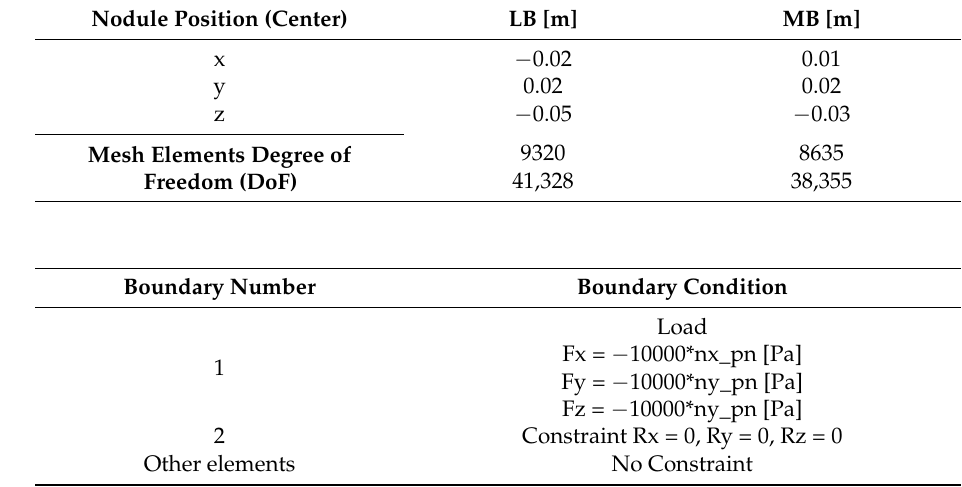
Figure 5. Three-dimensional (3D) model for FE analysis with 10-mm diameter inclusion embedded in breast tissue (LB) (Axes are in (m)). Table 2. Model parameters for the 3D FE analysis.